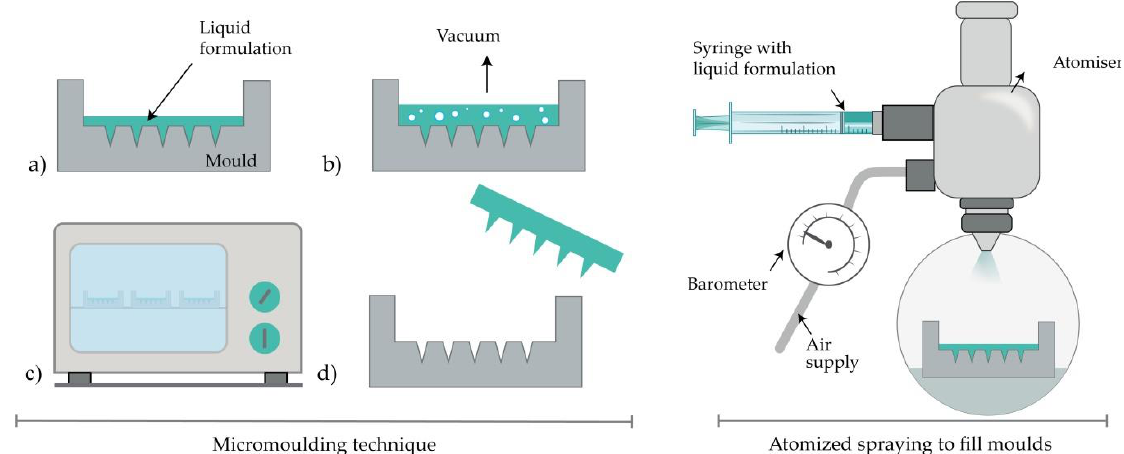
Figure 6. Left: MN production with micromolding (left) consisted of ( a ) pouring the liquid formulation, ( b ) vacuum degasification, ( c ) drying and ( d ) removal of MNs from the mold. Right: Atomized spraying to fill molds.